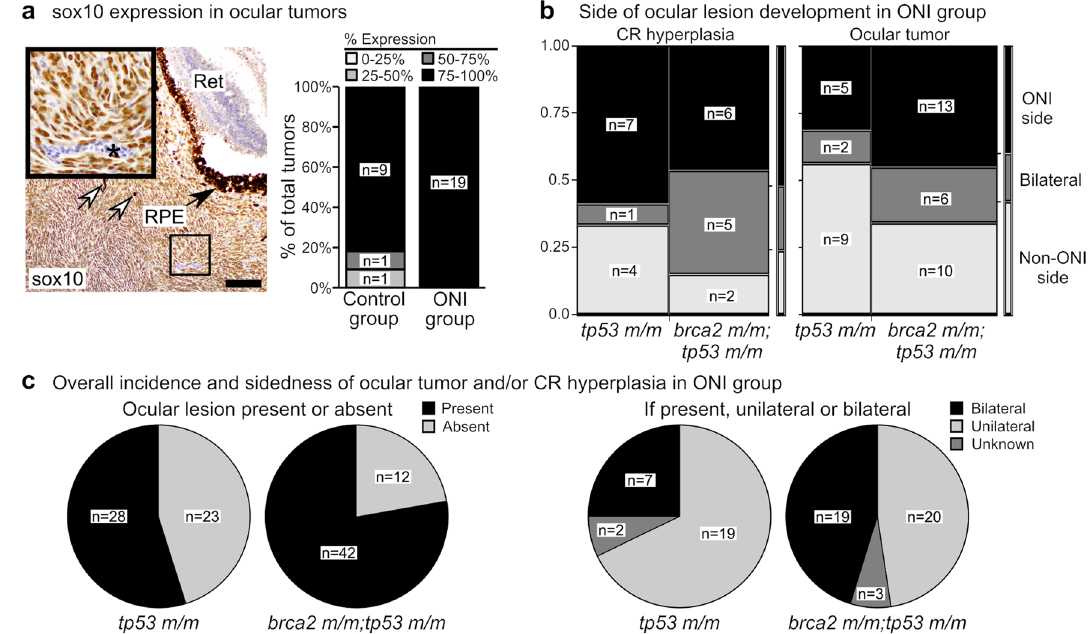
Figure 4. Optic nerve injury (ONI) and brca2 genotype exert variable effects on the development of proliferative and neoplastic lesions in the optic nerve pathway. ( a ) The majority of zebrafish ocular tumors highly express sox10 regardless of ONI status. White arrows indicate dispersed melanin pigment within tumors. Inset shows tumor cells with positive nuclear sox10 expression (brown chromogen). Asterisk indicates a blood vessel containing nucleated erythrocytes that do not express sox10. ( b ) In zebrafish that received ONI, most brca2 m/m;tp53 m/m zebrafish developed atypical spindle cells in the choroid rete (CR) on the injured side (ONI side) or bilaterally, in contrast to ocular tumor development. ( c ) In zebrafish that received ONI, brca2 m/m;tp53m/m zebrafish were more likely to develop ocular lesions (ocular tumor and/or hyperplastic spindle cells in the choroid rete) and these lesions were more likely to be bilateral. HE, hematoxylin and eosin; Ret, retina; RPE, retinal pigmented epithelium; ONI, optic nerve injury; CR, choroid rete. Scale bar = 50